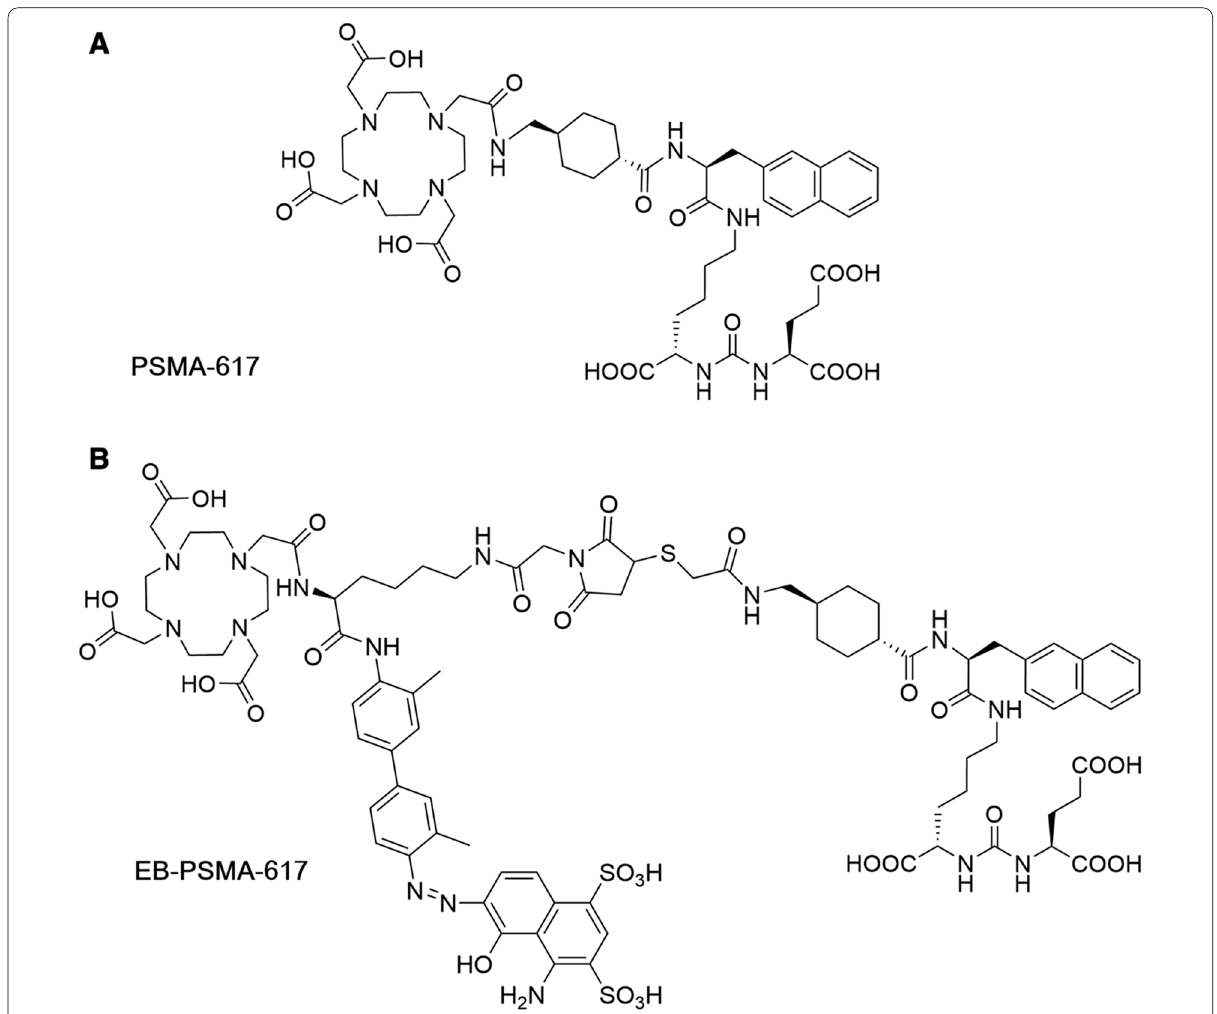
Fig. 1 Structural formula of PSMA-617 ( A ) and EB-PSMA-617 ( B